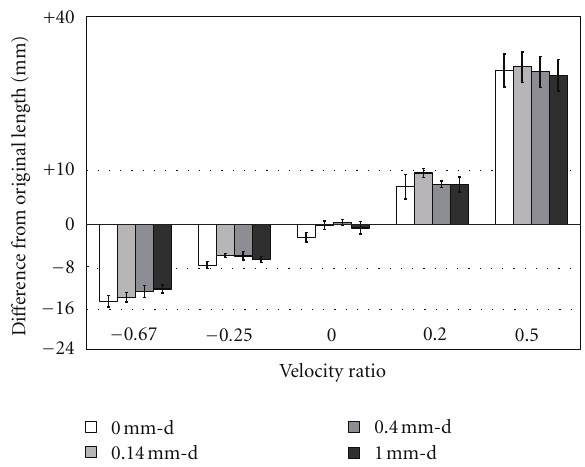
Figure 6: Di ff erences in the PSEs of perceived length from the original length in 0.00, 0.14, 0.40, and 1.00- mm-d roughness conditions. Dotted lines show theoretical values calculated from